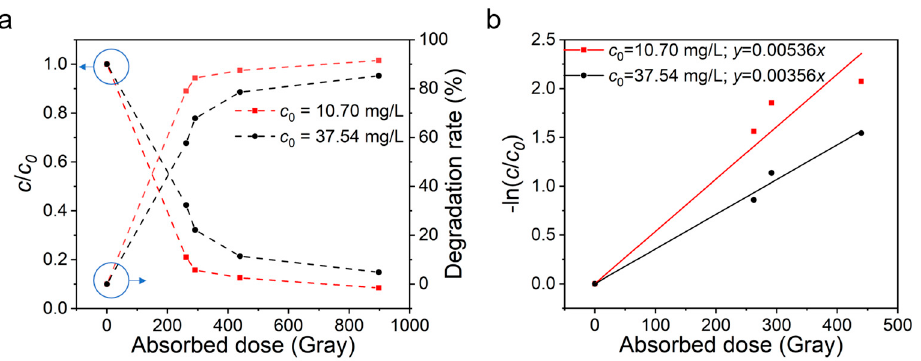
Figure 4. Effect of different initial concentrations of SMZ on degradation efficiency (energy = 80 keV; beam current = 1 mA; pH = 12): ( a ) Degradation of SMZ at different initial concentrations and absorbed doses; ( b ) pseudo-first-order dynamics of experimental data